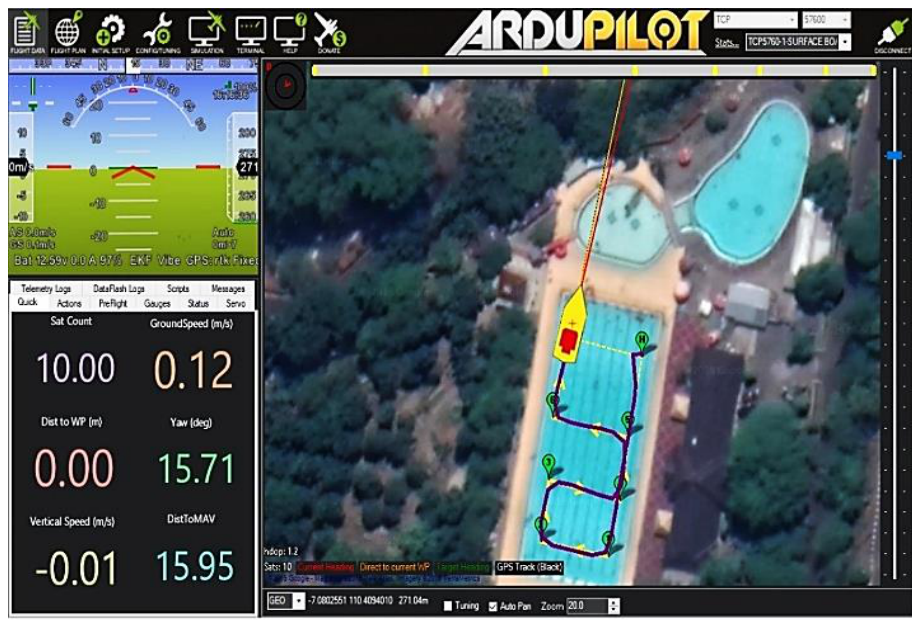
Figure 11. Ground Control Station (GCS).